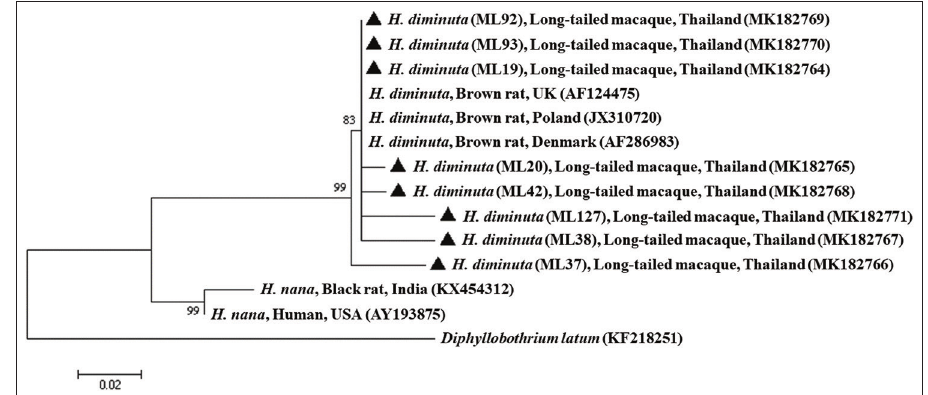
Figure-2: Phylogenetic tree based on partial 18S rRNA gene sequences of Hymenolepis diminuta based on the maximum likelihood method. Bootstrap percentages are shown at nodes. Diphyllobothrium latum is the outgroup. The isolates obtained in the current study are coded using triangular